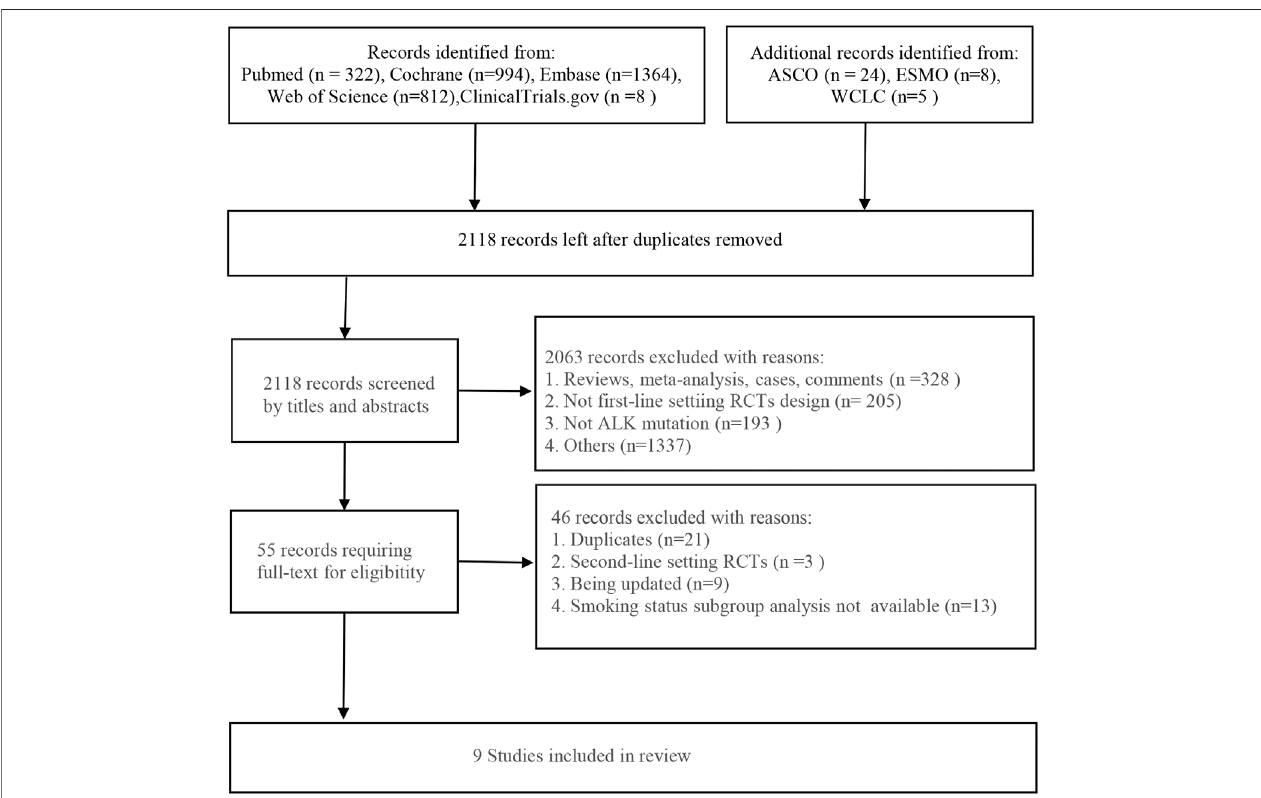
FIGURE1| Flowchartoftheliteraturescreening.ASCO,theAmericanSocietyofClinicalOncology;ESMO,theEuropeanSocietyforMedicalOncology;WCLC,the World Conference on Lung Cancer; RCTs, randomized controlled trials; ALK, anaplastic lymphoma kinase.